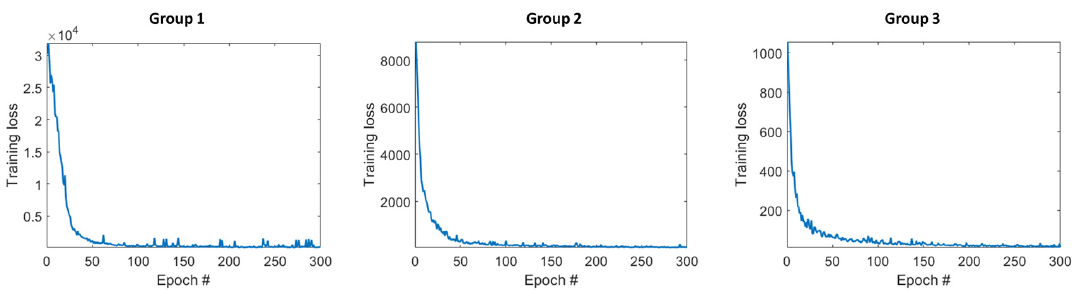
Figure 25. Training loss of different DRF groups with Res-U-net model for 99m Tc. Table 4. SSIM (mean ± SD) of different DRF groups for LC-SM, G-DSM, U-DSM, and R-DSM for 99m Tc.